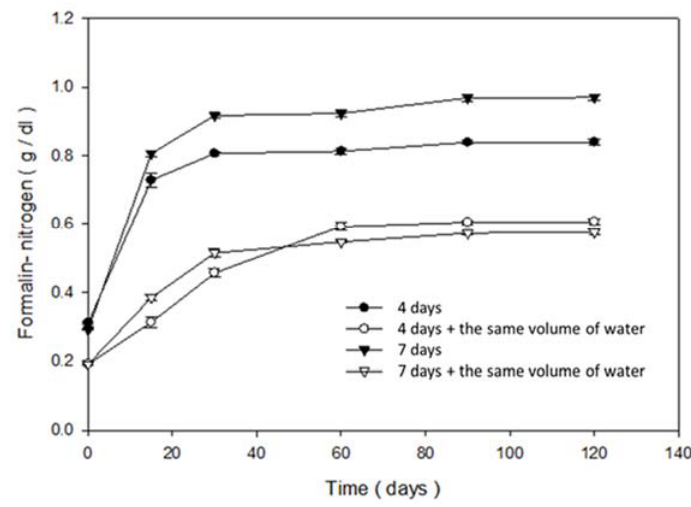
Figure 3. Changes in formaldehyde nitrogen during the brewing period of fish sauce of each group (— ● —: Group A; — ○ —: Group B; — ▼ —: Group C; — △ —: Group D).